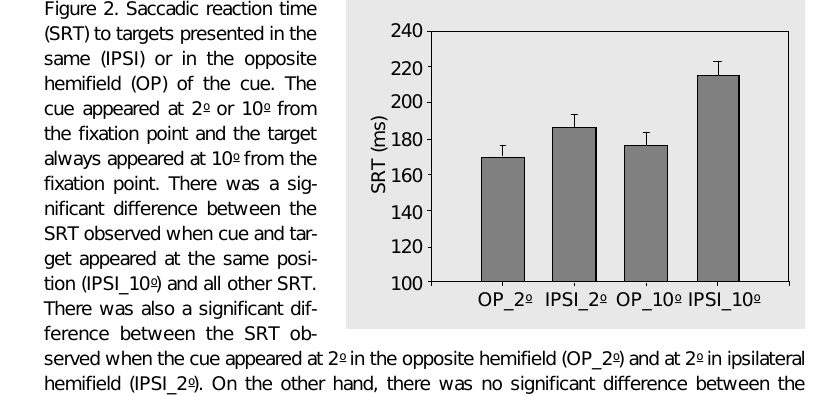
Figure 2. Saccadic reaction time (SRT) to targets presented in the same (IPSI) or in the opposite hemifield (OP) of the cue. The cue appeared at 2 º or 10 º from the fixation point and the target always appeared at 10 º from the fixation point. There was a sig- nificant difference between the SRT observed when cue and tar- get appeared at the same posi- tion (IPSI_10 º ) and all other SRT. There was also a significant dif- ference between the SRT ob- served when the cue appeared at 2 º in the opposite hemifield (OP_2 º ) and at 2 º in ipsilateral hemifield (IPSI_2 º ). On the other hand, there was no significant difference between the conditions in which the cue appeared at 2 º or 10 º in the contralateral hemifield. Pairwise comparisons were made with the Newman-Keuls test (P <